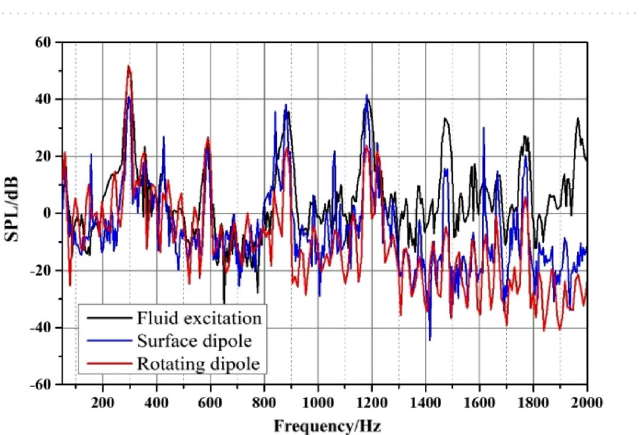
Figure 22. Directional distribution of outfield noise by the rotating dipole.